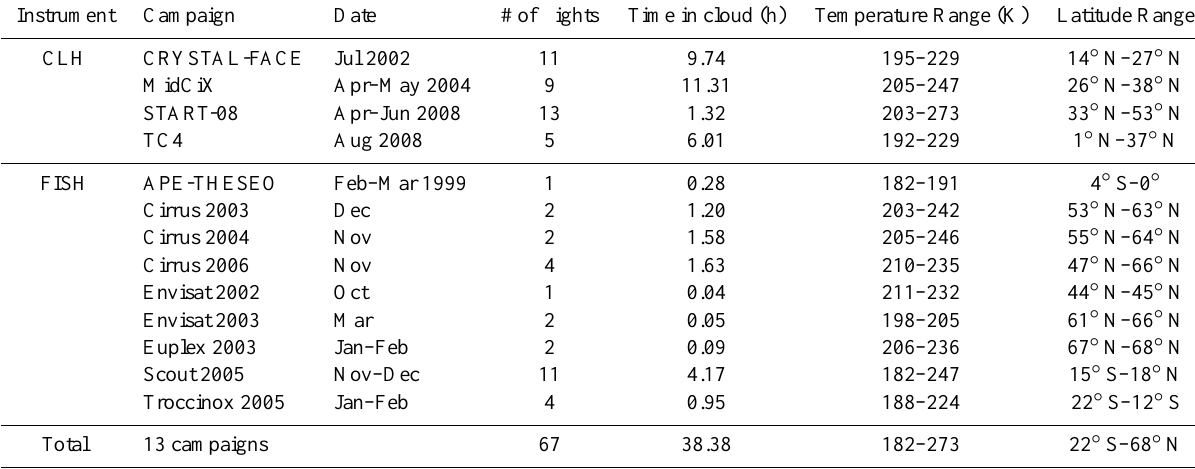
Table 1. Description of the flight campaigns used to develop the IWC dataset. Instrument Campaign Date Time in cloud (h) CLH CRYSTAL-FACE